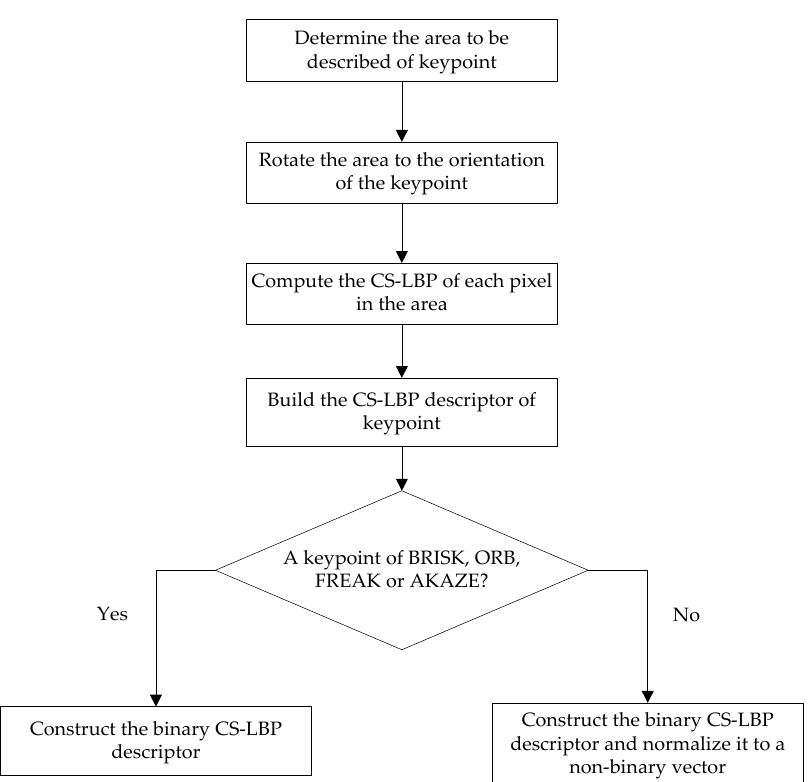
Figure 2. Flow chart for the CS-LBP description